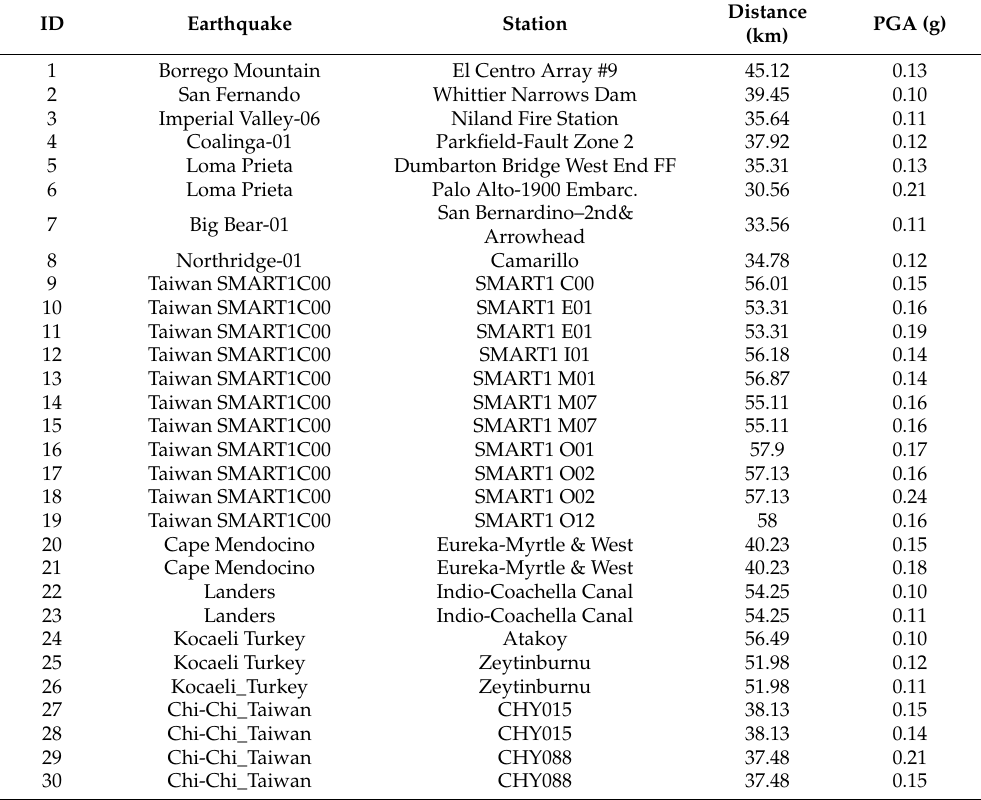
Table 3. Characteristics of Input